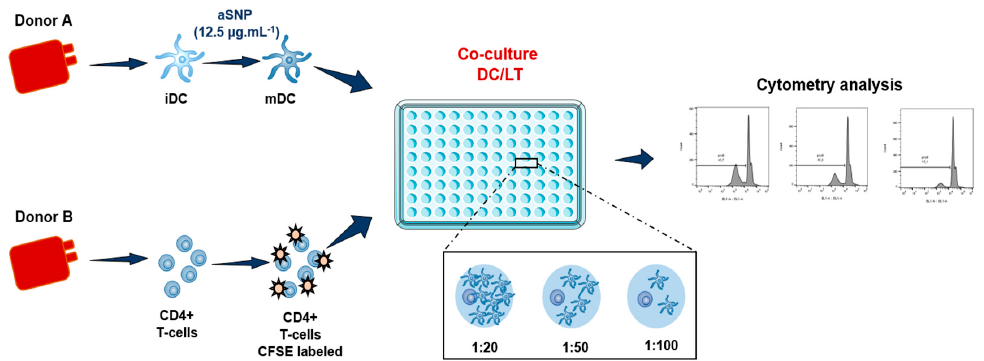
Figure 1. Allogeneic model of DCs and CD4 + T-cells co-culture with the different ratios tested. Cells are incubated in presence or absence of 12.5 µ g · mL − 1 of aSNP for 16 h. Treated MoDCs are co-cultured with allogeneic CD4 + T-cells labeled with CFSE at a ratio of 1:20 (1 MoDC for 20 CD4 + T-cells), 1:50 and 1:100). Proliferation is quantified after 5 or 6 days of co-culture as the percentage of CFSE low CD4 + T-cells.